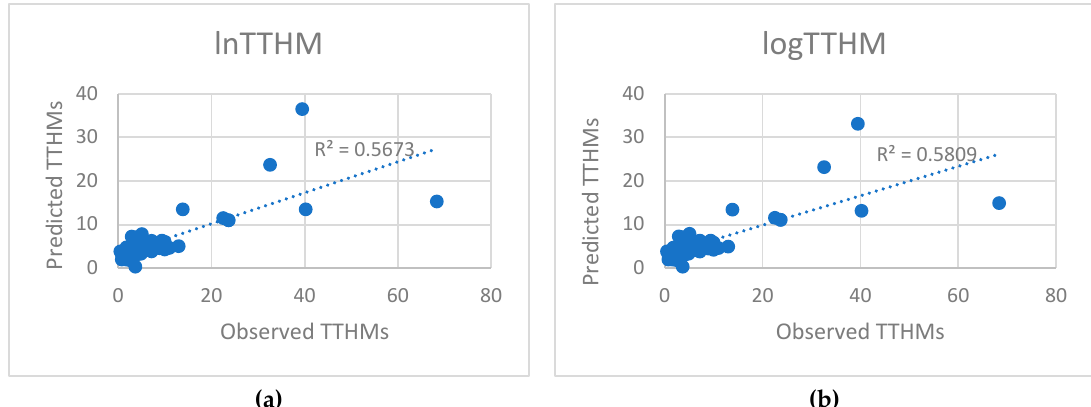
Figure 7. Error indicators for ( a ) models (2) and (3); ( b ) models (4) and (5).